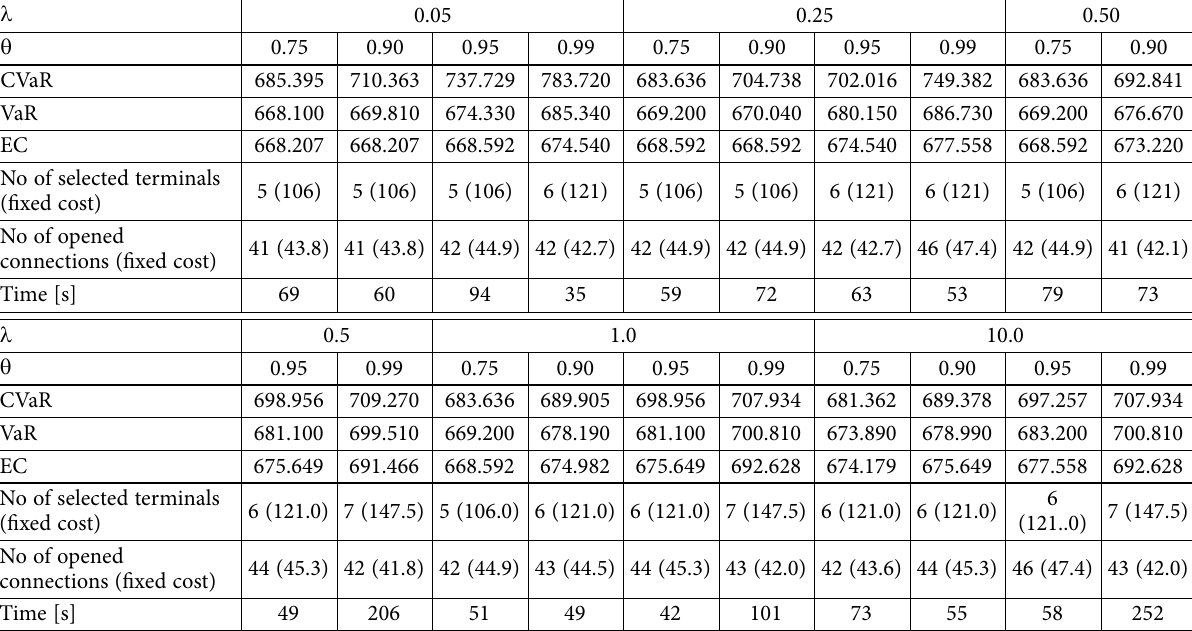
Table 4. Solutions of 2-stage MR model for case 8–1 (cost [$10 5 ])